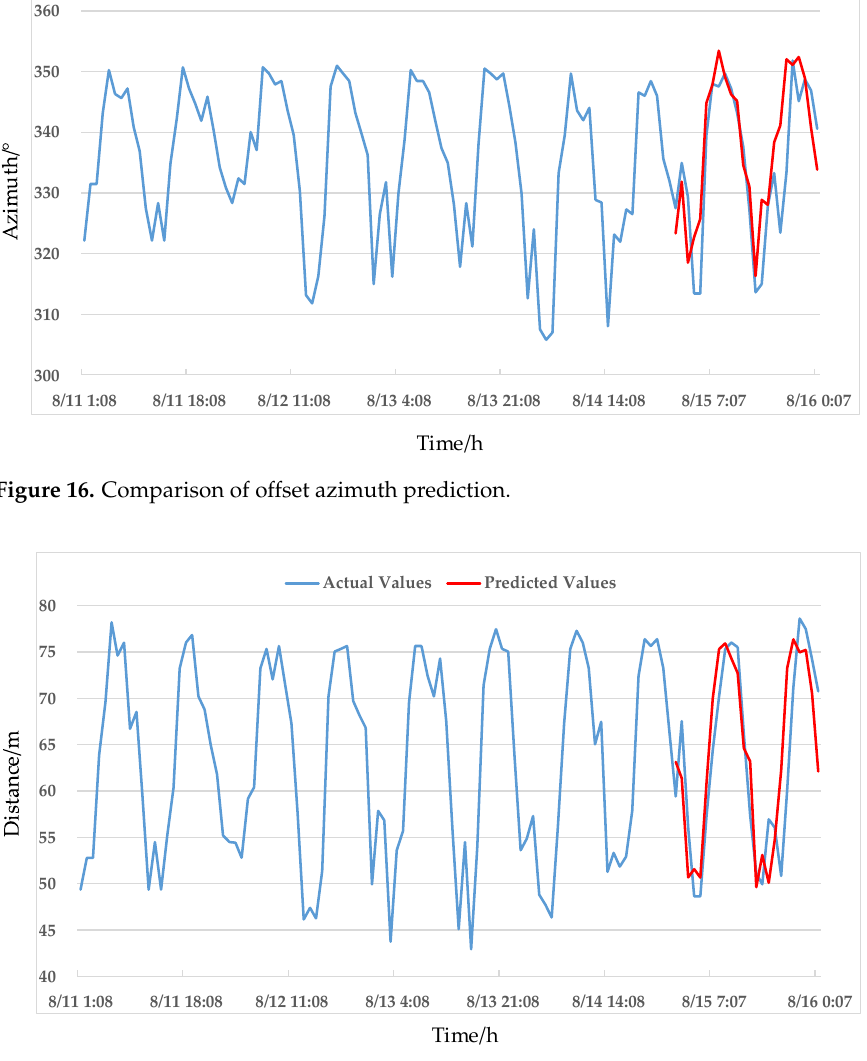
Figure 17. Comparison of offset distance prediction.